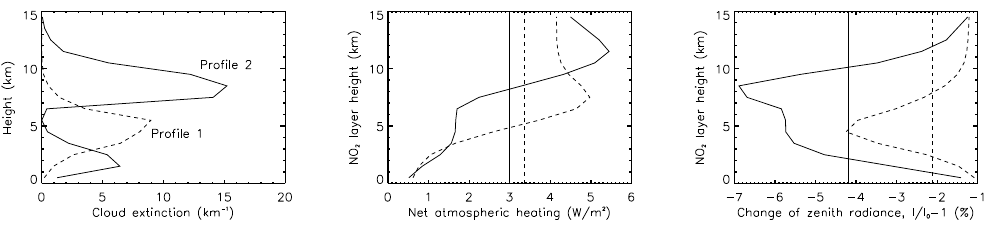
Fig. 5. Left: cloudSat/MODIS cloud extinction profiles used in radiative transfer simulations; middle: net heating dependence on the 1km NO 2 layer midpoint. Dashed(solid) lines are for CloudSat profiles 1(2); vertical lines are for uniform distributions of NO 2 inside the clouds; right: as in middle but for zenith radiances.